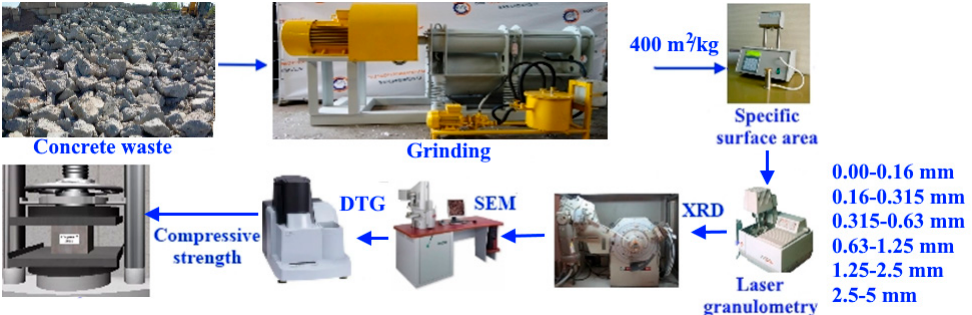
Figure 1. Flow chart of the procedure.